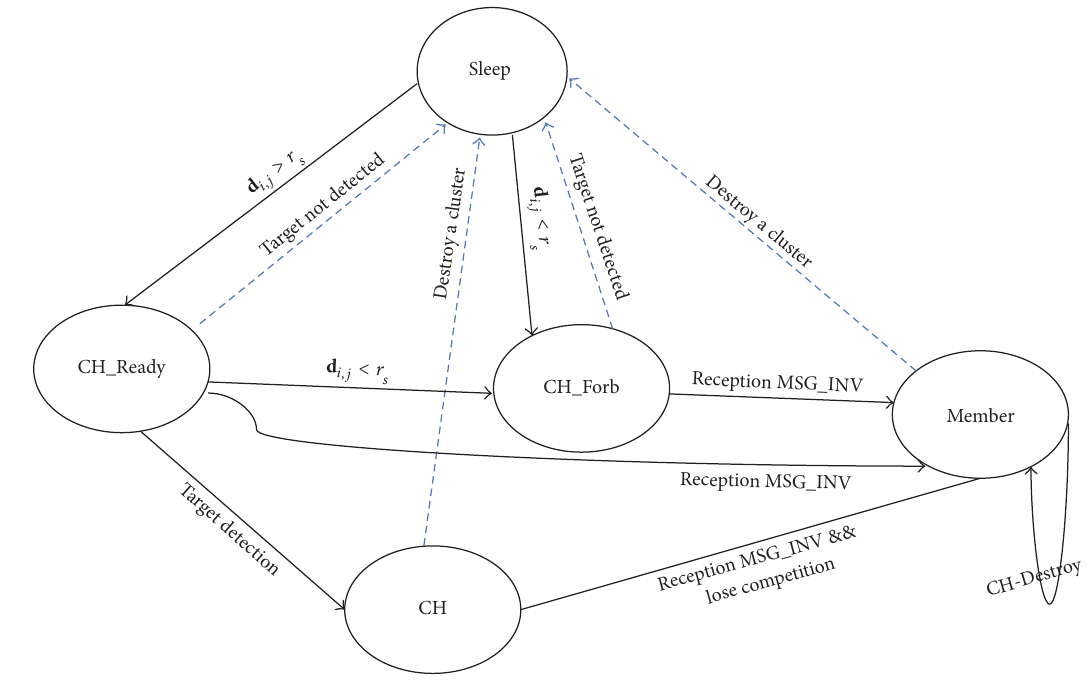
Figure 8: State diagram of the algorithm.